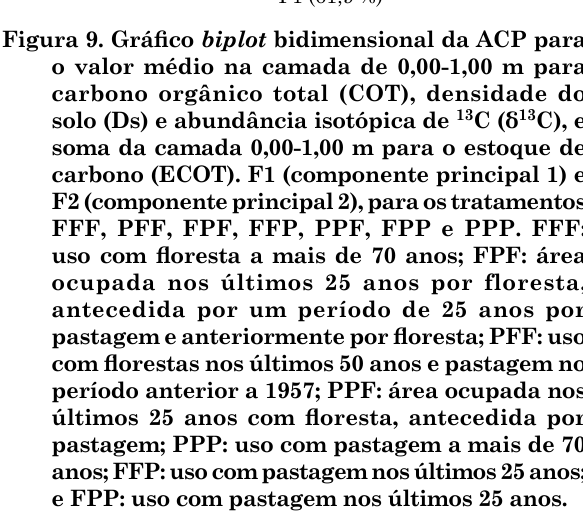
FFFPPFPFFPPPδ Figura 9. Gráfico biplot bidimensional da ACP para o valor médio na camada de 0,00-1,00 m para carbono orgânico total (Cot), densidade do solo (Ds) e abundância isotópica de 13 C (δ 13 C), e soma da camada 0,00-1,00 m para o estoque de carbono (ECot). F1 (componente principal 1) e F2 (componente principal 2), para os tratamentos FFF, PFF, FPF, FFP, PPF, FPP e PPP. FFF: